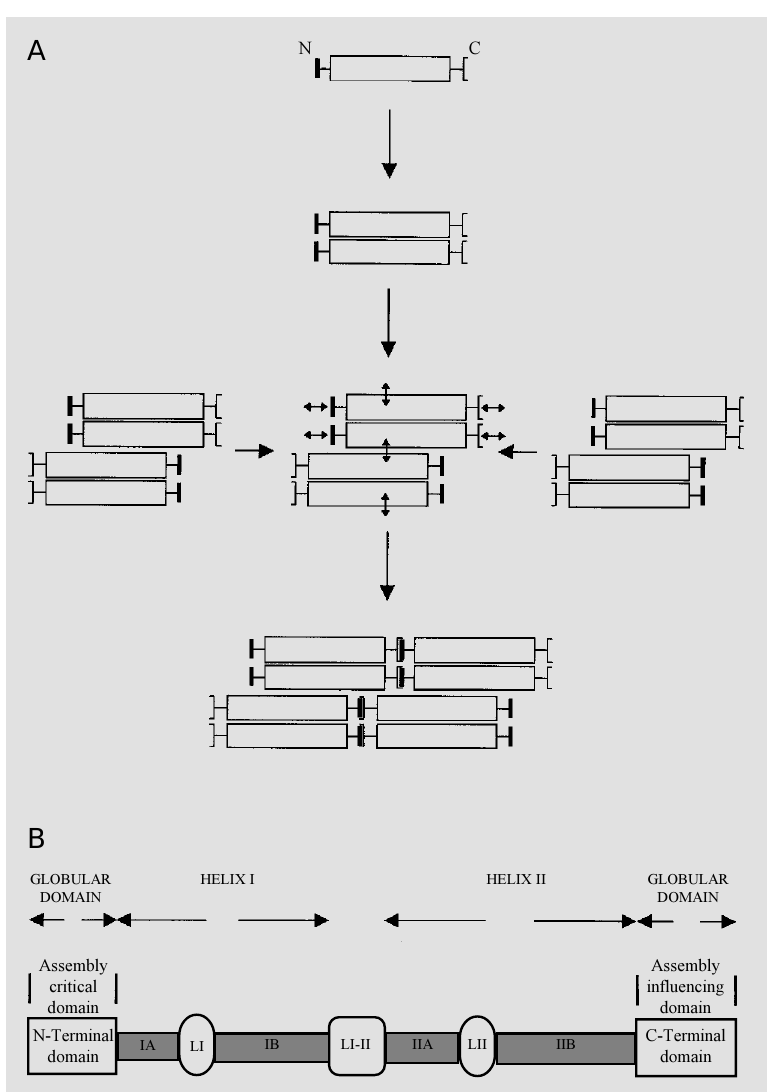
Figure 1 - A , Schematic representation of association of intermediate filament (IF) subunits into dimers, tetramers, and octamers. In IF dimers monomers are found parallel and in register, and association of monomers into dimers takes place through their rod domains. IF tetramers form through the lateral association of dimers, but here dimers are antiparallel and staggered. Filament elongation occurs via a head-to-tail mechanism. B , Schematic representation of an IF subunit. A core domain (rod) is flanked by a head (N-terminal) domain and a tail (C-terminal) domain. The head domain is critically important for filament assembly (elongation) (see Refs. 1-5 for